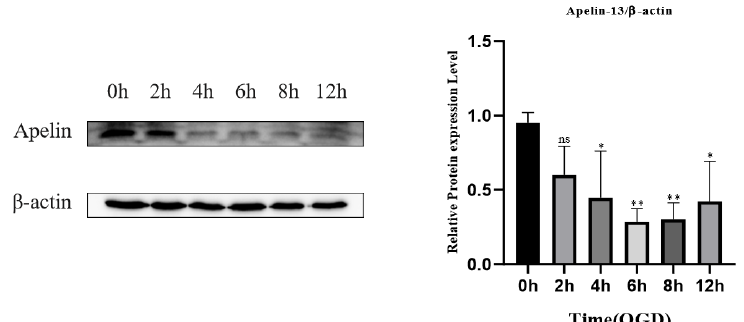
Figure 5. ( A ) The top 20 pathways associated with the up-regulated mRNAs through KEGG path- way analysis. ( B ) The top 20 pathways associated with the down-regulated mRNAs through KEGG pathway